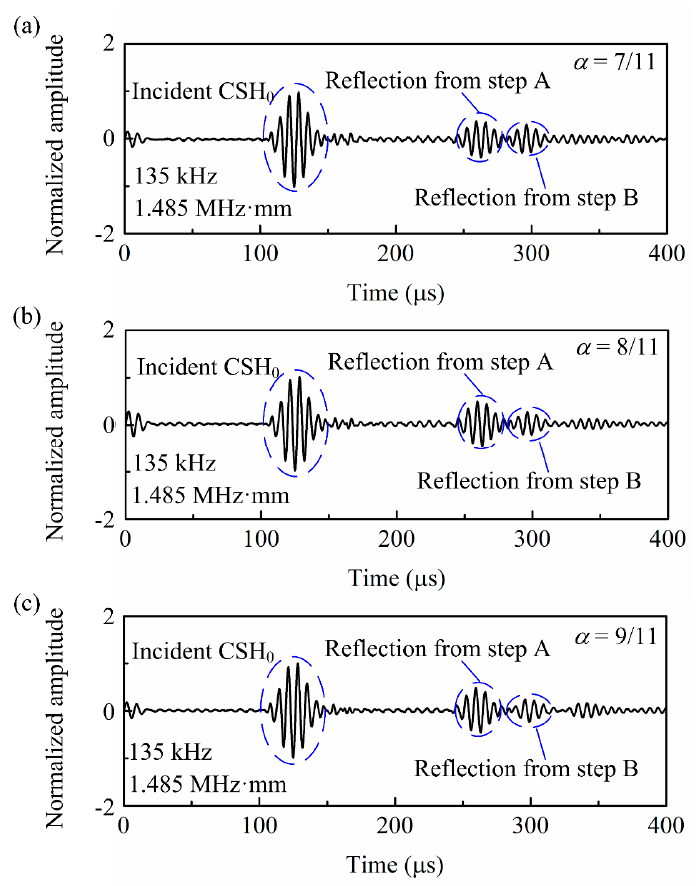
Figure 11. Experimental CSH 0 wave signals showing the reflections from the rectangular notches with different depths.